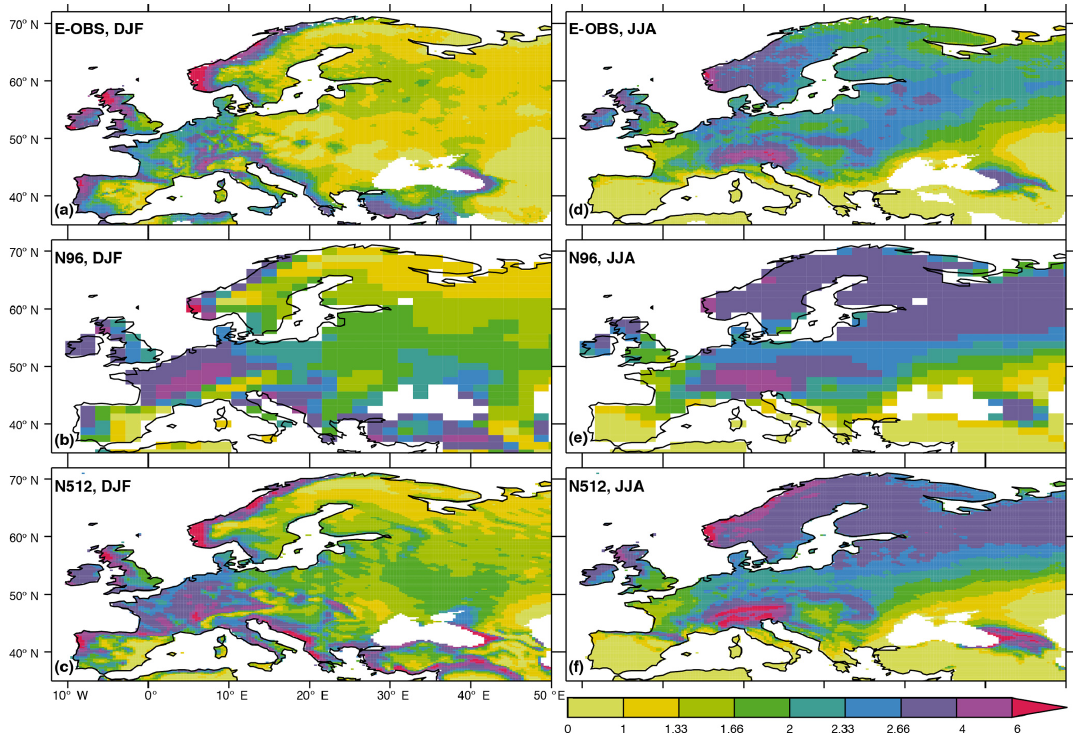
Figure 1. Climatological mean precipitation (mmday − 1 , 1986–2011) according to (a, d) E-OBS, (b, e) N96 and (c, f) N512 for (a– c) December–February and (d–f) June–August. Contour levels are not equidistant to better capture mesoscale